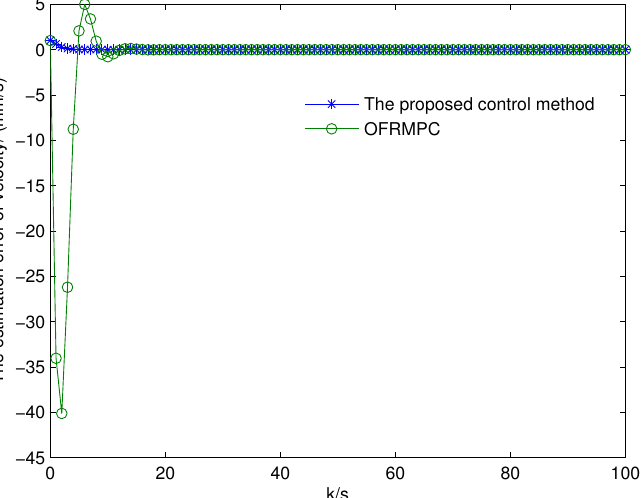
Figure 9. The estimation error of velocity for the proposed method and OFRMPC method.